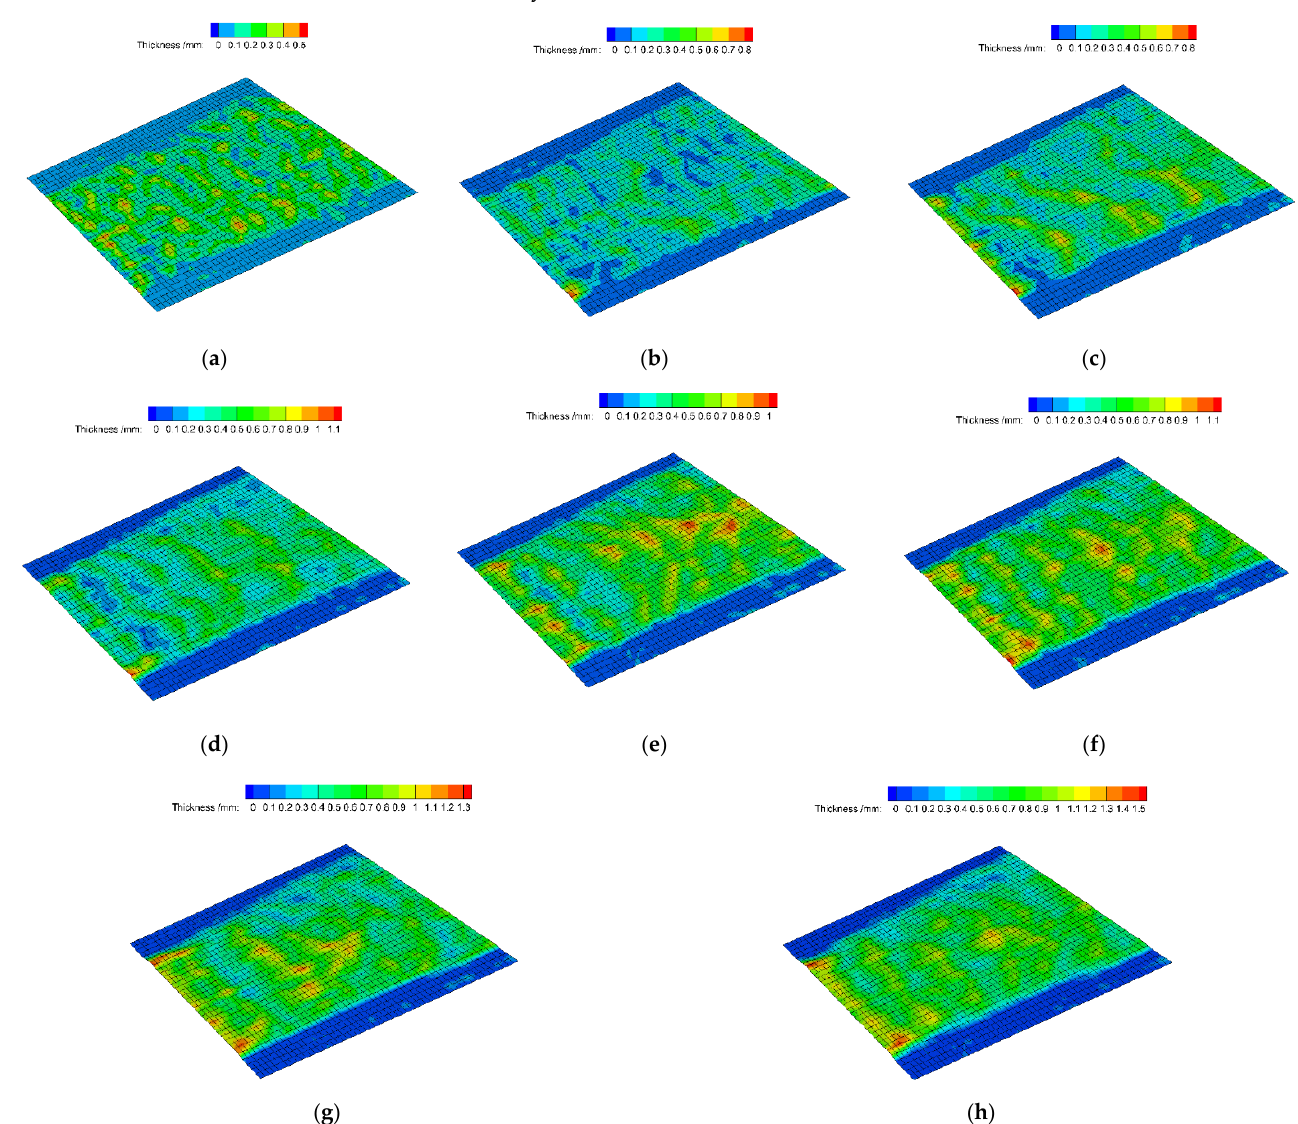
Figure 9. The DIP measurements at 25 m/s wind speed: ( a ) Re f = 16.5; ( b ) Re f = 23.6; ( c ) Re f =47.1; ( d ) Re f = 70.7; ( e ) Re f = 94.3; ( f ) Re f = 117.9; ( g ) Re f = 141.4; ( h ) Re f = 165. When Re f = 47.1–117.9, the average thickness of the water film increased linearly with the increase in Re f . Under the combined action of the surface tension of the water and the shear force of the airflow, a complete transverse fluctuation was formed on the surface of the water film and was transmitted in the backward direction. As the thickness of the water film was sufficient to satisfy the fluctuation transmission at the corresponding speed, the RMS f value remained small in an interval. No major variation was observed in the fluctuation transmission speed.